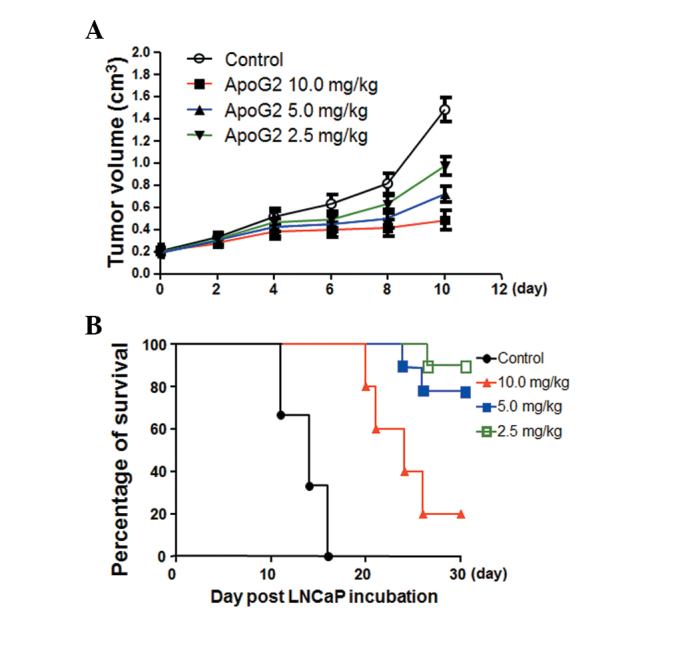
Effects of ApoG2 on the tumor volume and survival rate of athymic nude mice bearing LNCaP cells. (A) Tumor volume of control and ApoG2 treatment groups. All results are expressed as the mean ± standard error of the mean of three independent experiments. (B) Survival rate of athymic nude mice in the control and ApoG2 treatment groups. ApoG2, apogossypolone.